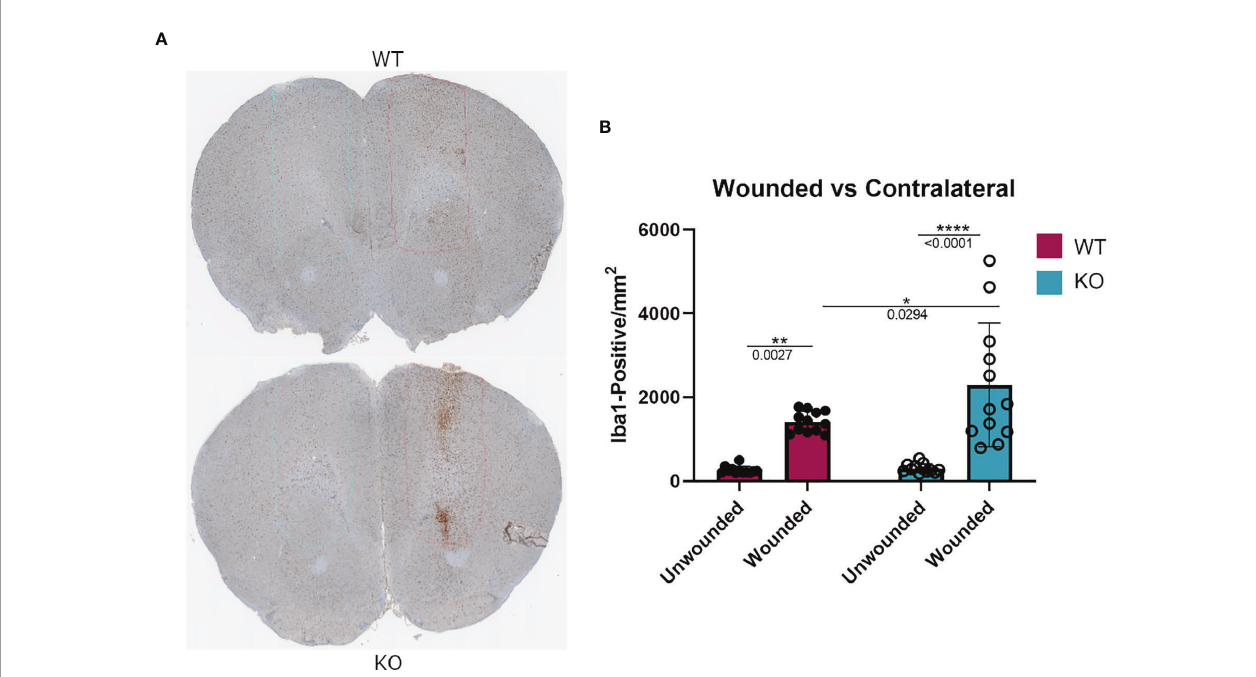
FIGURE 7 | Increased Iba1 + cell in fi ltration at needle track of surgically wounded Dgka -/- and WT mice in acute brain injury model. (A) Representative cross sections highlighting needle track and unwounded contralateral cortex. (B) Quanti fi cation of Iba1 + cells in the needle track demonstrates an increase in cell in fi ltration in wounded Dgka -/- brains versus that in the contralateral, unwounded side. Each data point represents one of four brain sections cut from the site of needle injection, from each of n = 3 mice per group. Error bars: SD. *p < 0.05, **p < 0.01, ****p < 0.0001; Two-way ANOVA with Tukey post-hoc